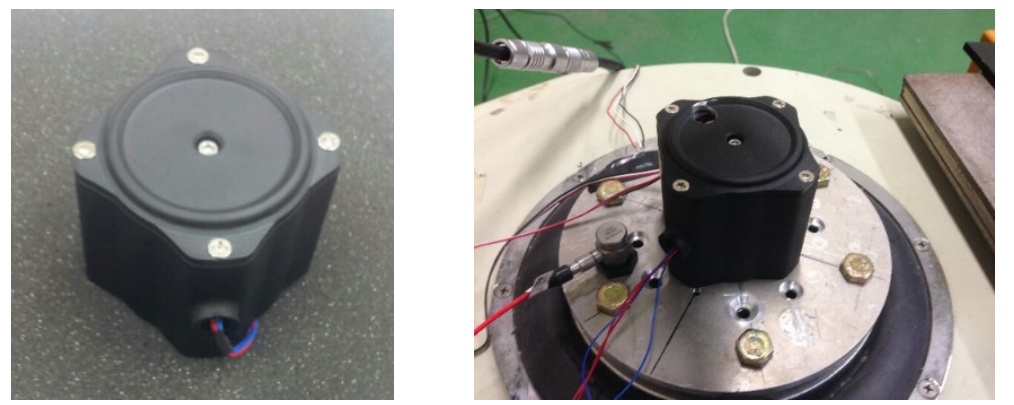
Figure 10. The VEH device and the vibrator it was on.